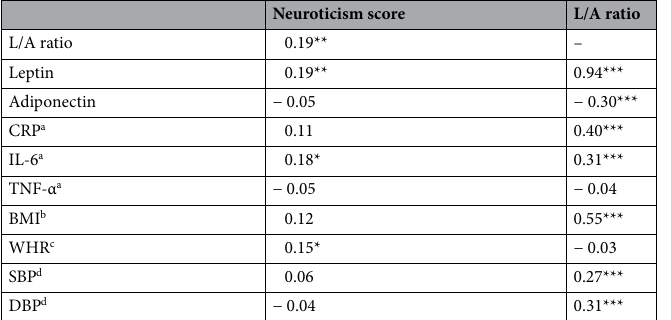
Table 2. Spearman’s correlation coefficients (ρ) in the total study population (N = 218). BMI body mass index, WHR waist-hip ratio, SBP systolic blood pressure, DBP diastolic blood pressure, L/A leptin/adiponectin. *p < 0.05; **p < 0.01; ***p < 0.001. Missing data for: a Sixteen patients; b Four patients; c Thirteen patients and two controls; d Two patients.